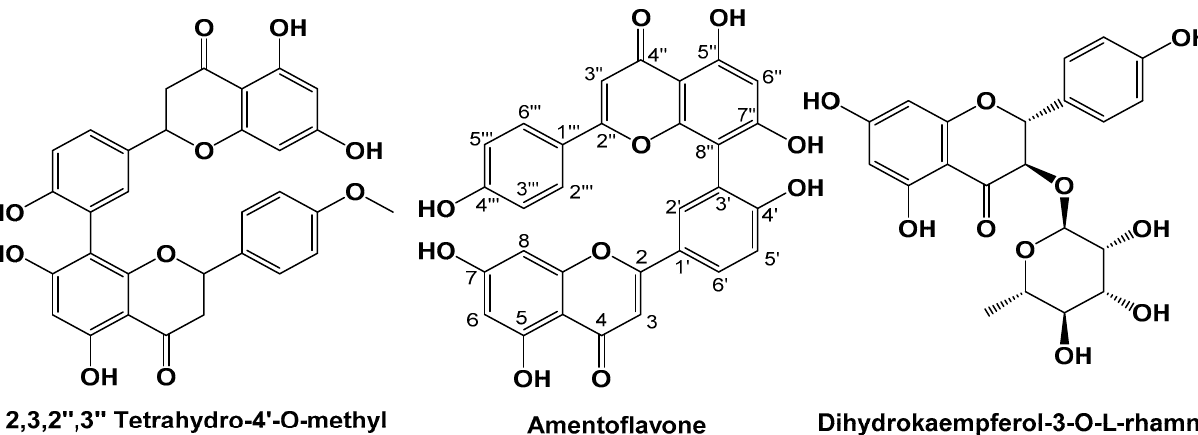
Figure 1. Chemical structures of the isolated compounds from CRME .